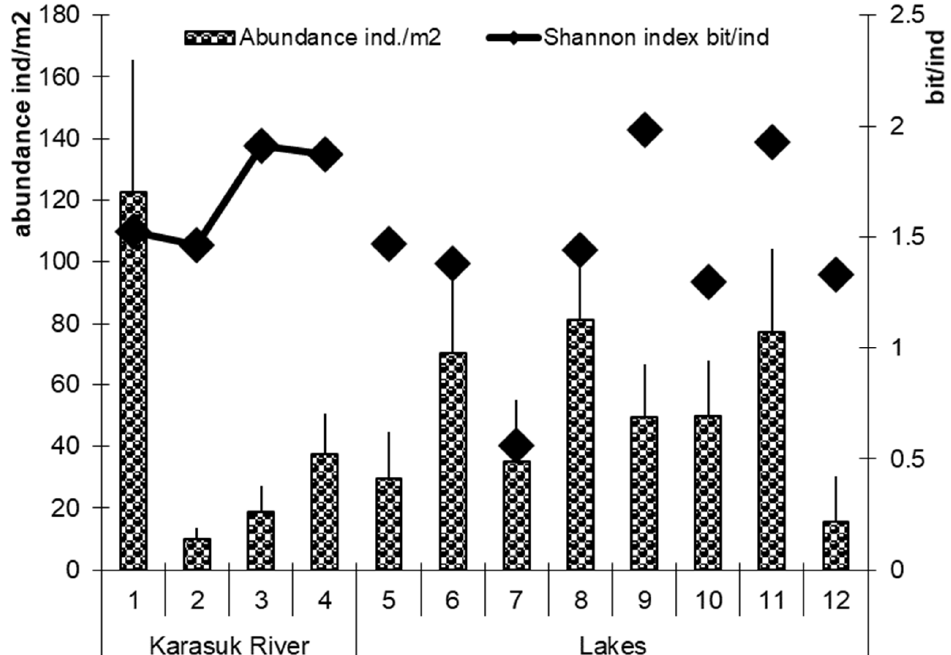
Figure 3. Diversity and abundance of gastropods in water bodies of Northern Kulunda: Karasuk River, upstream near Bystrukha village (1); Karasuk River, upstream near Tchernovka village (2); Karasuk River, downstream near Gramotino village (3); Karasuk River, downstream Sorochikha village (4); Lake Astrodym (5); Lake Krotovo (6); Lake Kusgan (7); Lake Melkoye (8); Lake Titovo (9); Lake Krivoye—Blagodatnoye reach (10); Lake Krivoye—Sopatoye reach (11); Lake Krivoye— Gusinoye reach (12).